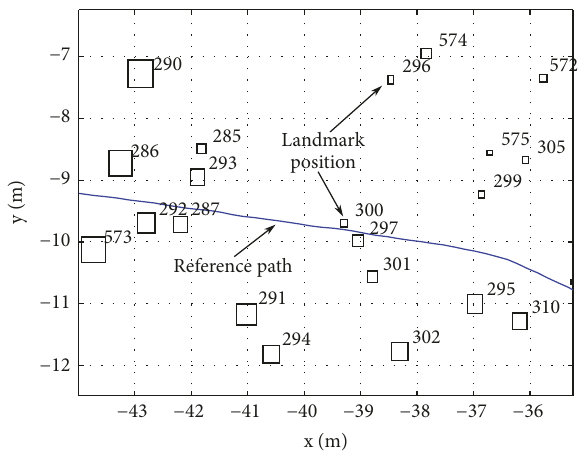
Figure 14: Map building result.